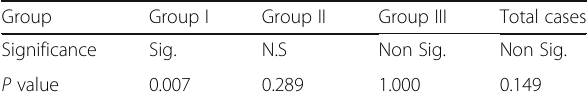
Table 13 Statistical significance for relation between echocardiography findings severity versus dyslipidemia in the